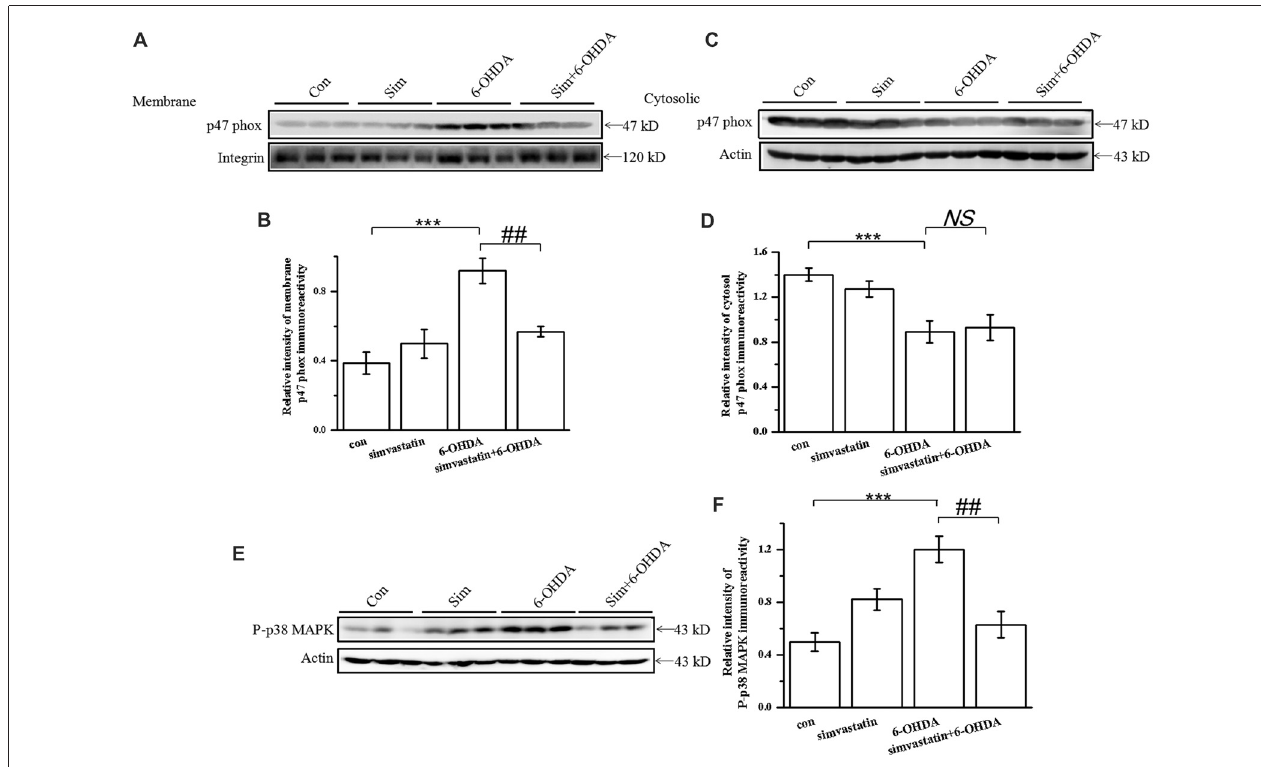
FIGURE 8 | Simvastatin inhibited the activity of NADPH oxidase and p38 AMPK in midbrain samples in the unilaterally 6-OHDA-lesioned mouse model of PD. p47 phox subunit protein levels were determined in lysates of midbrain tissue. Supernatant containing solubilized membrane or cytosol proteins was collected; membrane p47 phox (A) and cytosol p47 phox (C) expression was detected using western blot. Relative quantitative analysis of membrane p47 phox (B) and cytosol p47 phox (D) expression performed using ImageJ. Data were obtained from three independent experiments. (E) Protein levels of P-p38 evaluated by western blot. (F) Relative quantitative analysis of P-p38. Data were obtained from five independent experiments. Statistical analysis by Dunnett’s T3 or LSD post hoc test based on ANOVA; data expressed as mean ± SEM. ∗∗∗ P < 0.001, ## P < 0.01. NS, not significant.